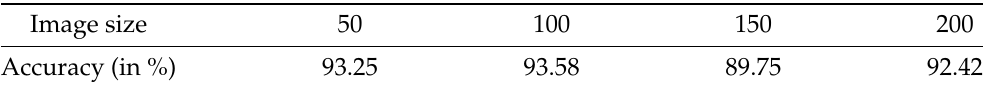
Table 7. Results obtained for different image sizes keeping batch size and epochs at 100 and dropout at 0.5.